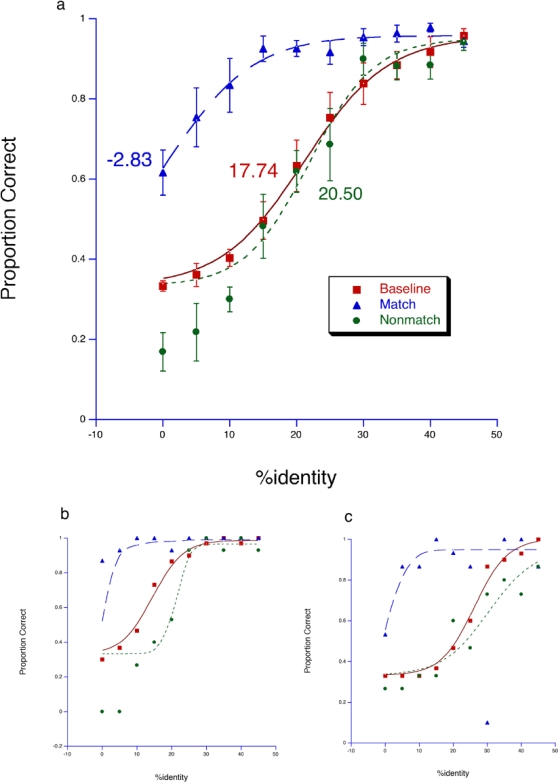
Sensitivity to face identity in real-stimulus conditions.The logistic function 1/(1+exp(−(x−c)/a)) was fitted to the data, in which ‘a’ and ‘c’ are free parameters that determine the midpoint and the slope of the psychometric function. The fraction of trials in which participants correctly identified the test face is plotted in relation to the identity percentage contained in test faces. Data from baseline with no adaptation (squares), adaptation to matching anti-face (triangles), and adaptation to non-matching anti-face (circles) are shown. The recognition threshold for each condition was taken to be the inflection point of the corresponding curve and shown accordingly. (a) Average of all participants. Standard errors are shown. (b and c) Individual data from two participants.